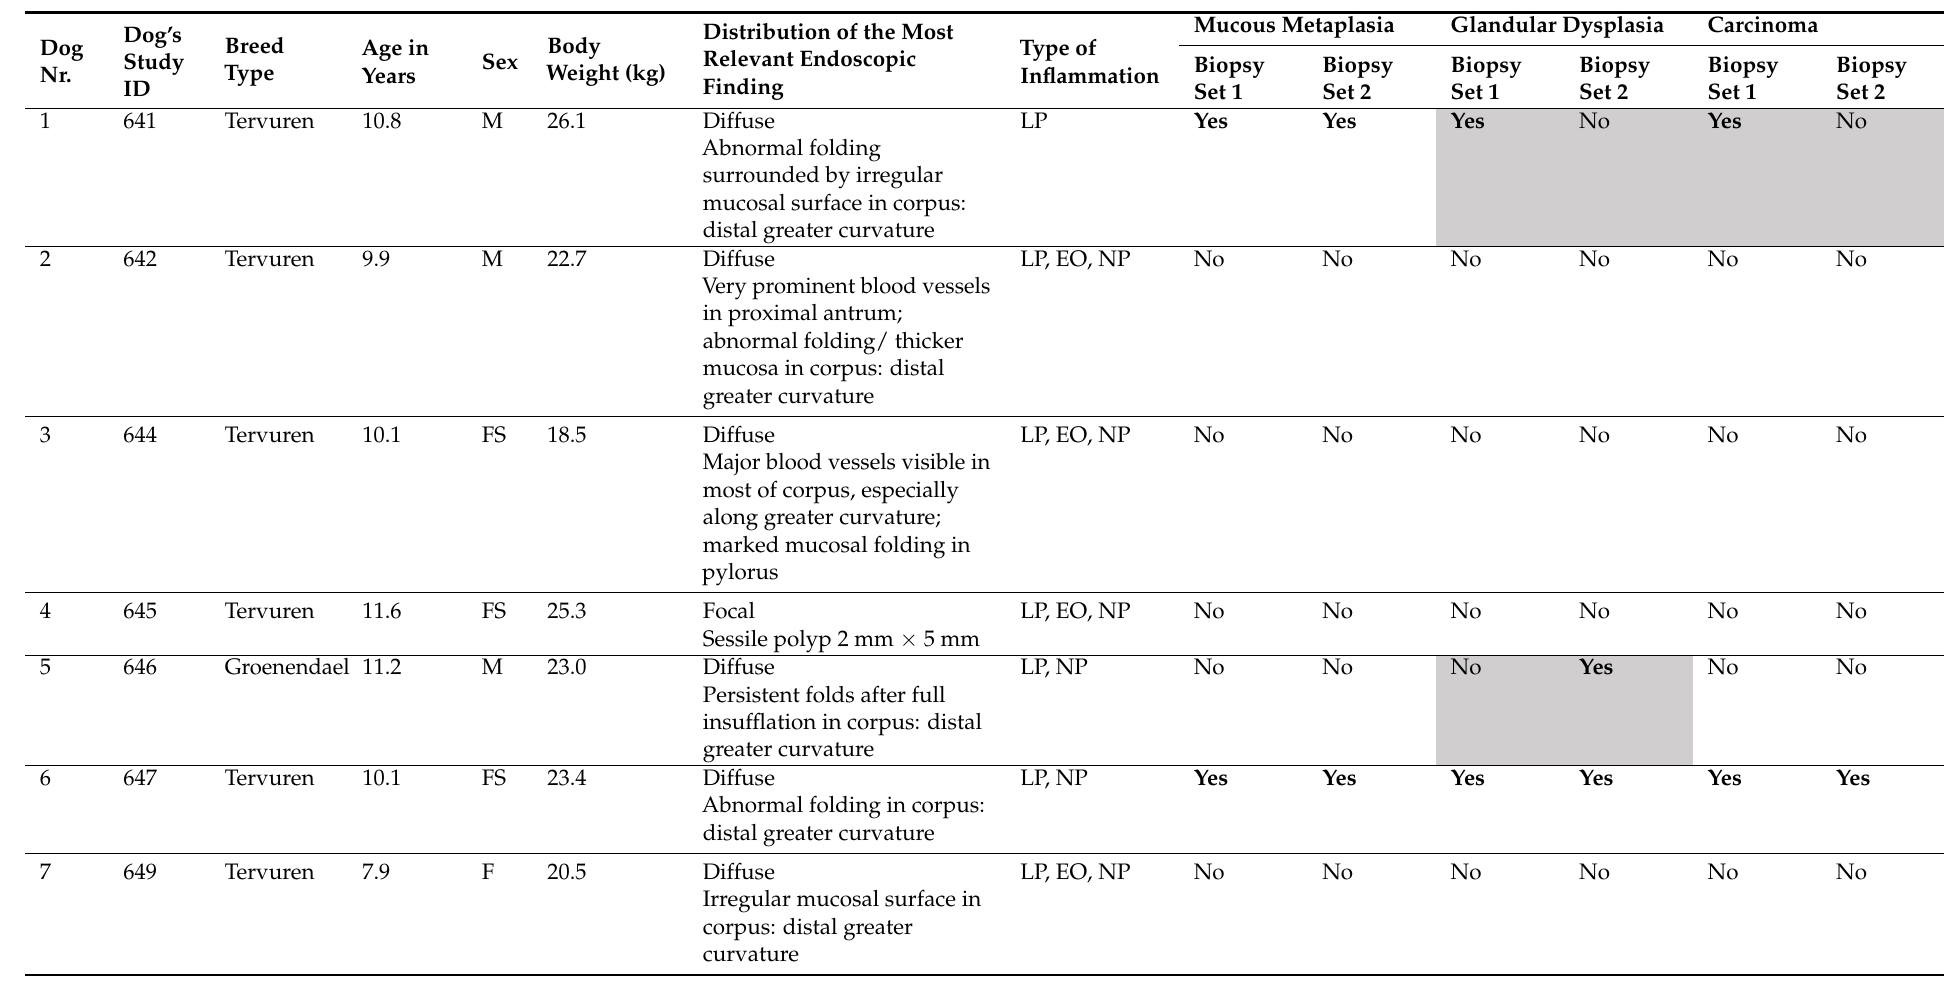
Table 3. Signalment of 30 Belgian shepherd dogs, findings during endoscopy, and histology from gastric mucosal biopsies: (1) sampling directed by